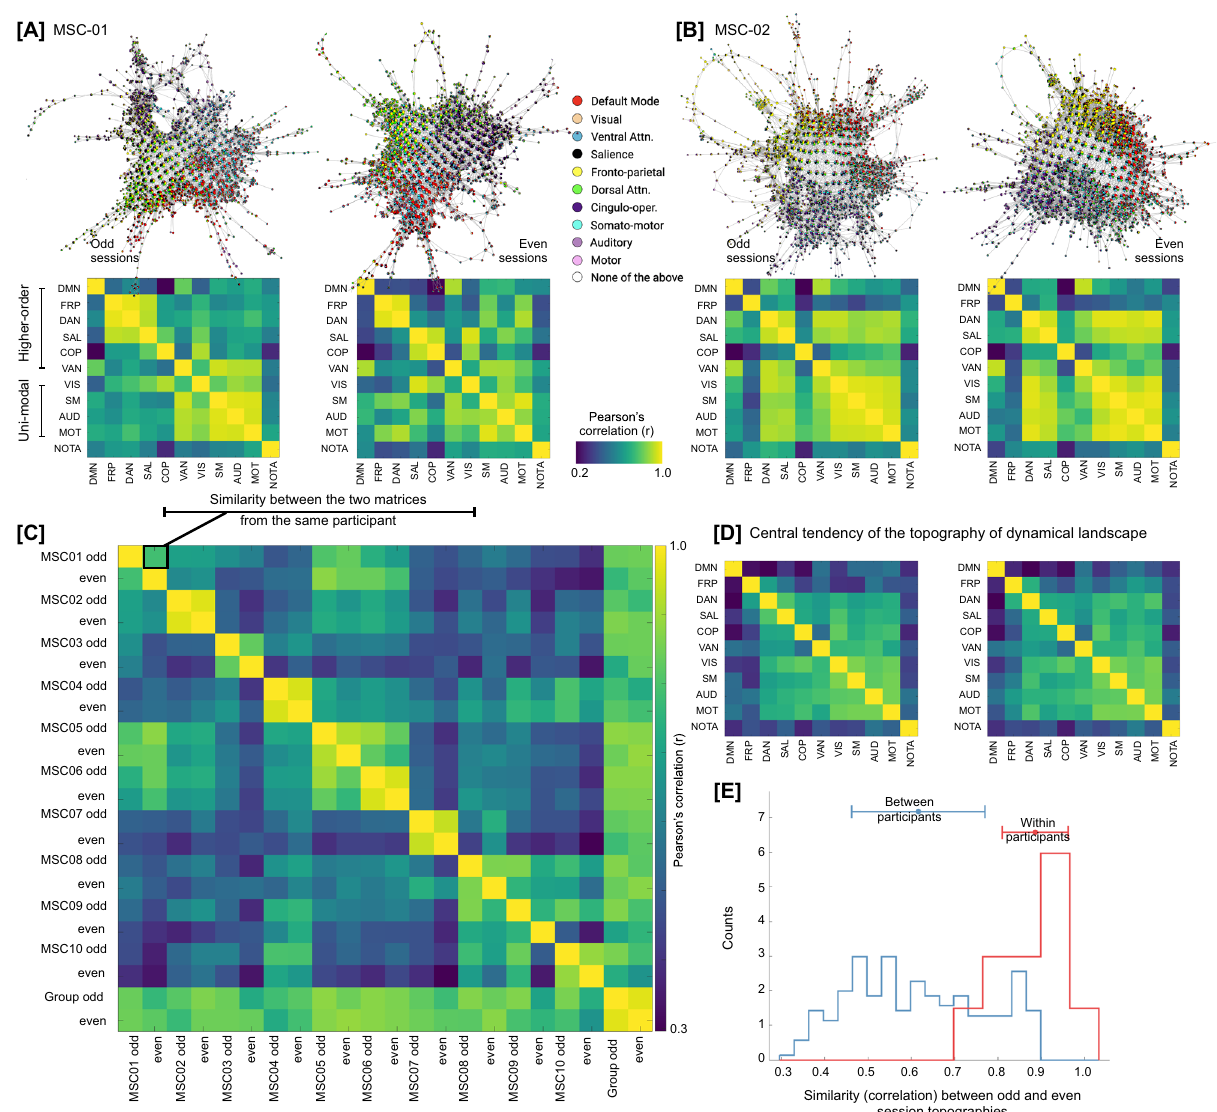
Fig. 4 | Dynamical landscapes and their RSN-based topography are subject- speci fi c.A , B ShowsMapper-generatedgraphsannotatedbyRSNactivationfortwo representative participants (MSC01-02). Both split halves (odd and even sessions) are shown for each participant. For each half, the fi gure also shows a similarity (correlation) matrix between RSNs, where a high correlation between two RSNs suggestsco-location (or co-activation) on the Mapper-generated graph.Asevident throughMapper-graphannotationsandbetweennetworkcorrelations,therewasa highdegreeofsimilaritybetweentwohalvesofthesameparticipant. C Toquantify between-vswithin-participantcorrespondenceacrossnetworksimilaritymatrices,